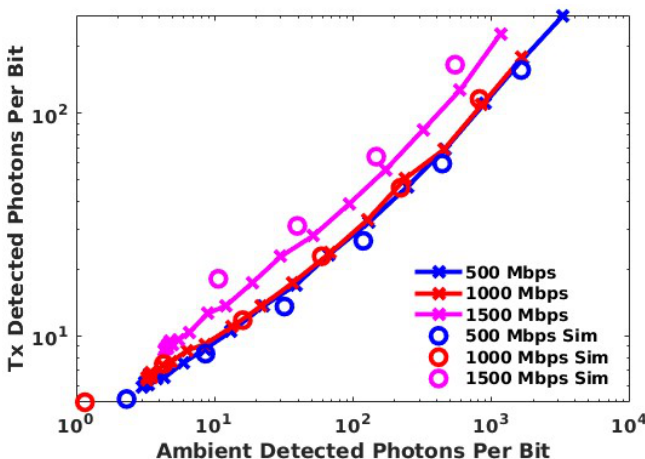
Figure 8. A comparison of the measured and simulated irradiances needed to support three data rates as the number of detected ambient light photons per bit time is increased.